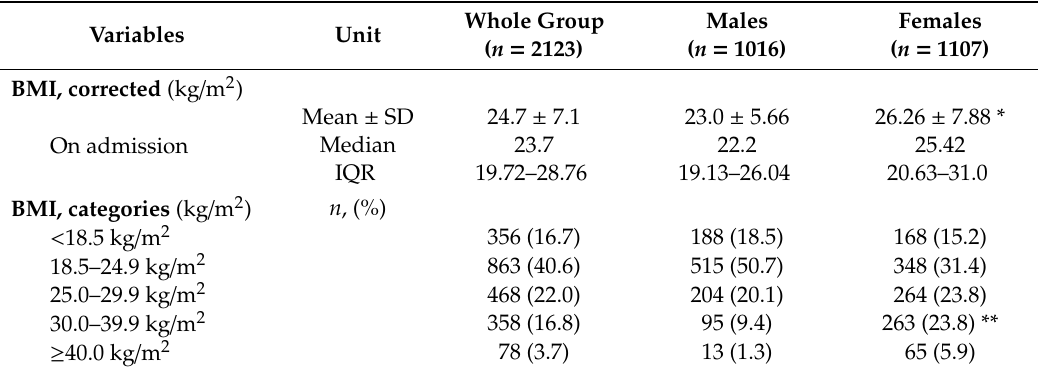
Table 2. Body mass index classification by gender on